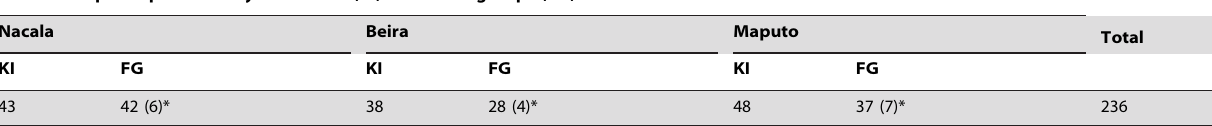
Number of participants in Key interviews (KI) and focus groups